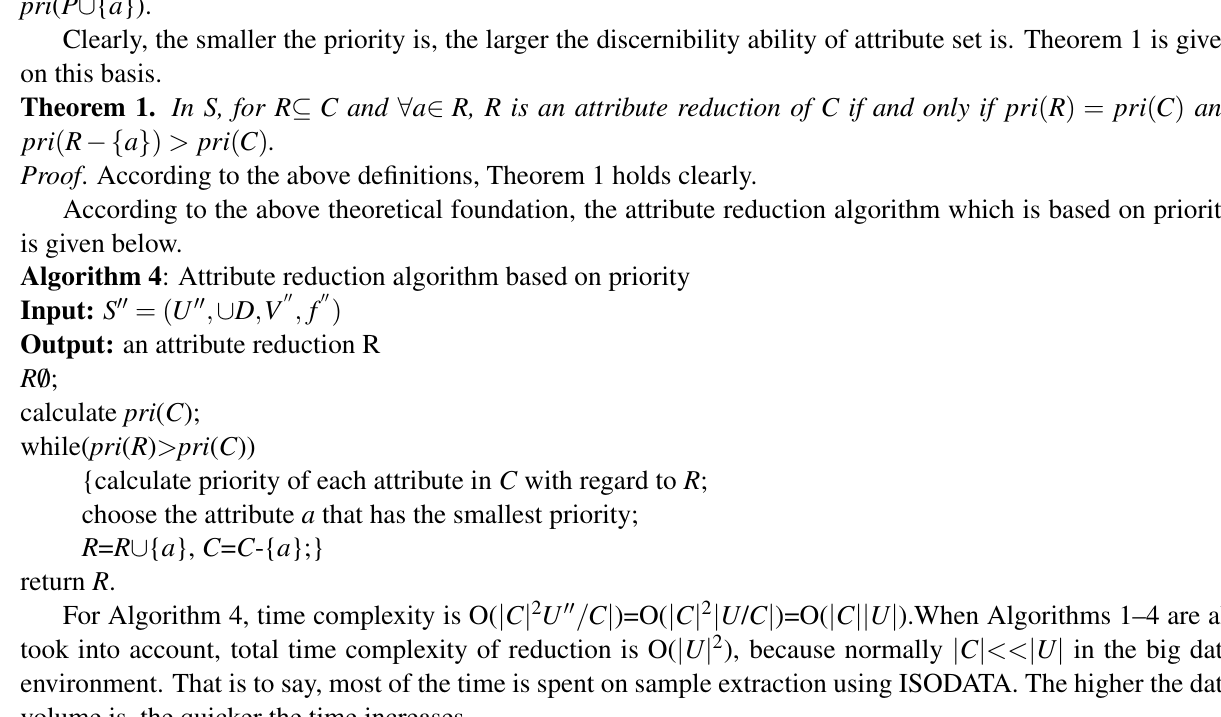
Algorithm 4 : Attribute reduction algorithm based on priority